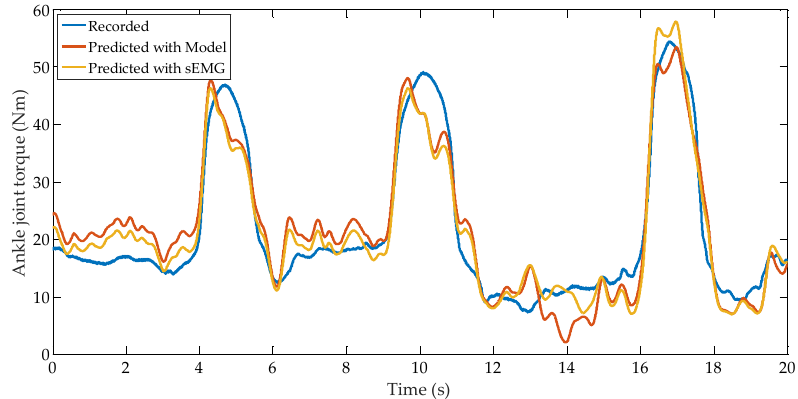
Figure 12. Ankle joint torque prediction results with musculoskeletal model and sEMG.